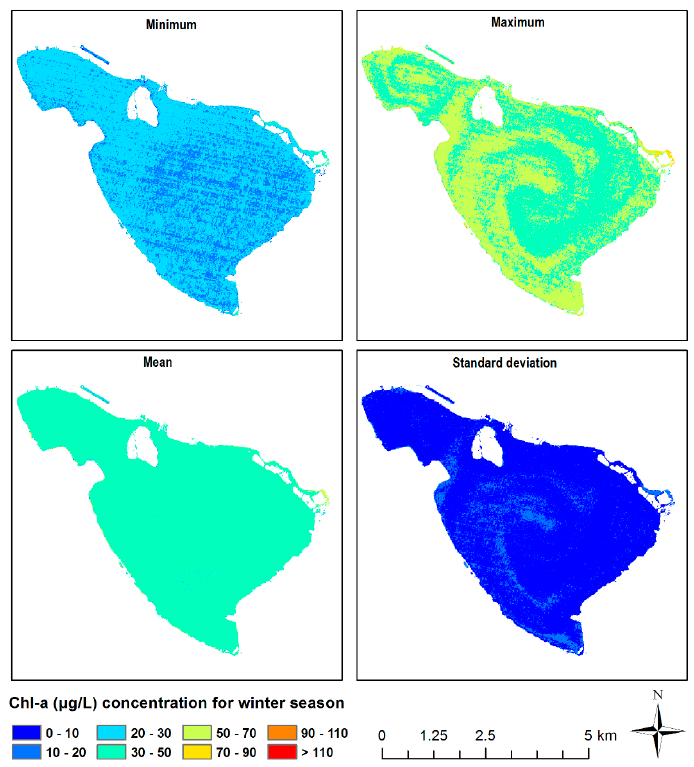
Figure A5. Chl- a concentration for a winter season.